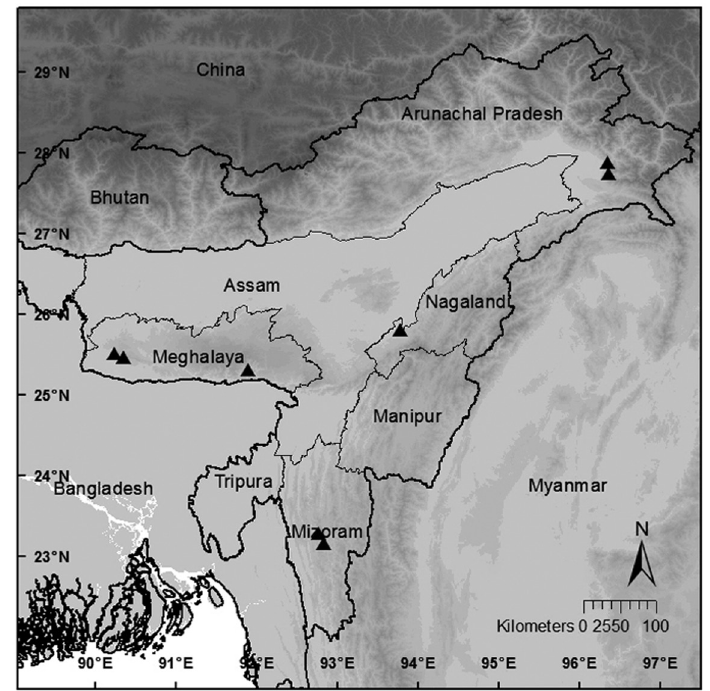
Fig. 39. Map showing the location of B. megaptera A.DC.